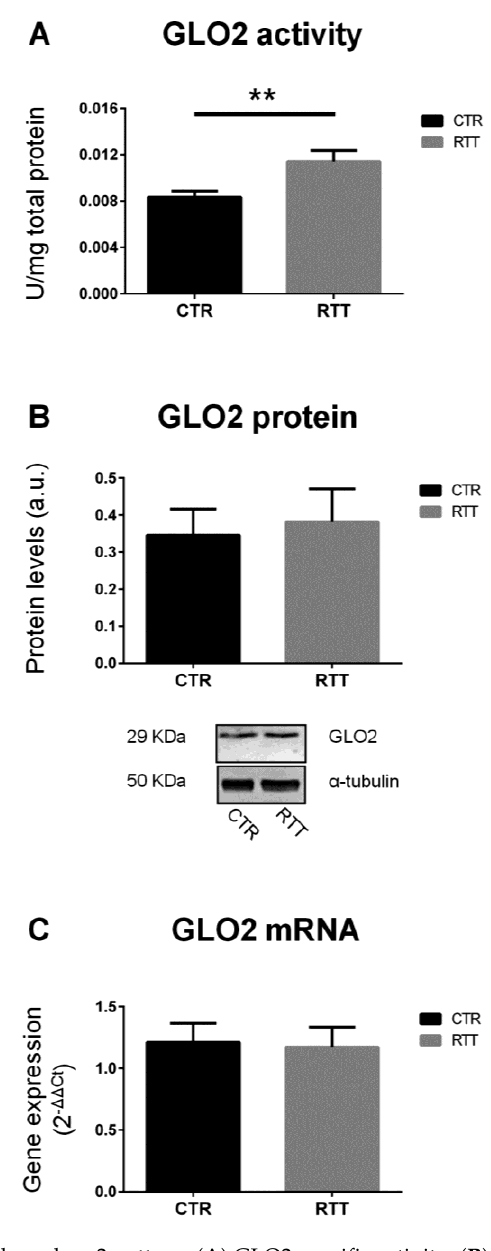
Figure 2. Assessment of glyoxalase 2 pattern. ( A ) GLO2 specific activity; ( B ) GLO2 protein levels, with representative (inverted) Western blots; ( C ) glo2 gene expression levels. Data of real time RT-PCR were given as 2 − ∆∆ Ct , using rpl13a as the reference, and one of the controls as the internal calibrator. All the data were expressed as means ± SD. CTR, control; RTT, Rett syndrome. ** p < 0.01. Data were analyzed by a t -test for independent groups.